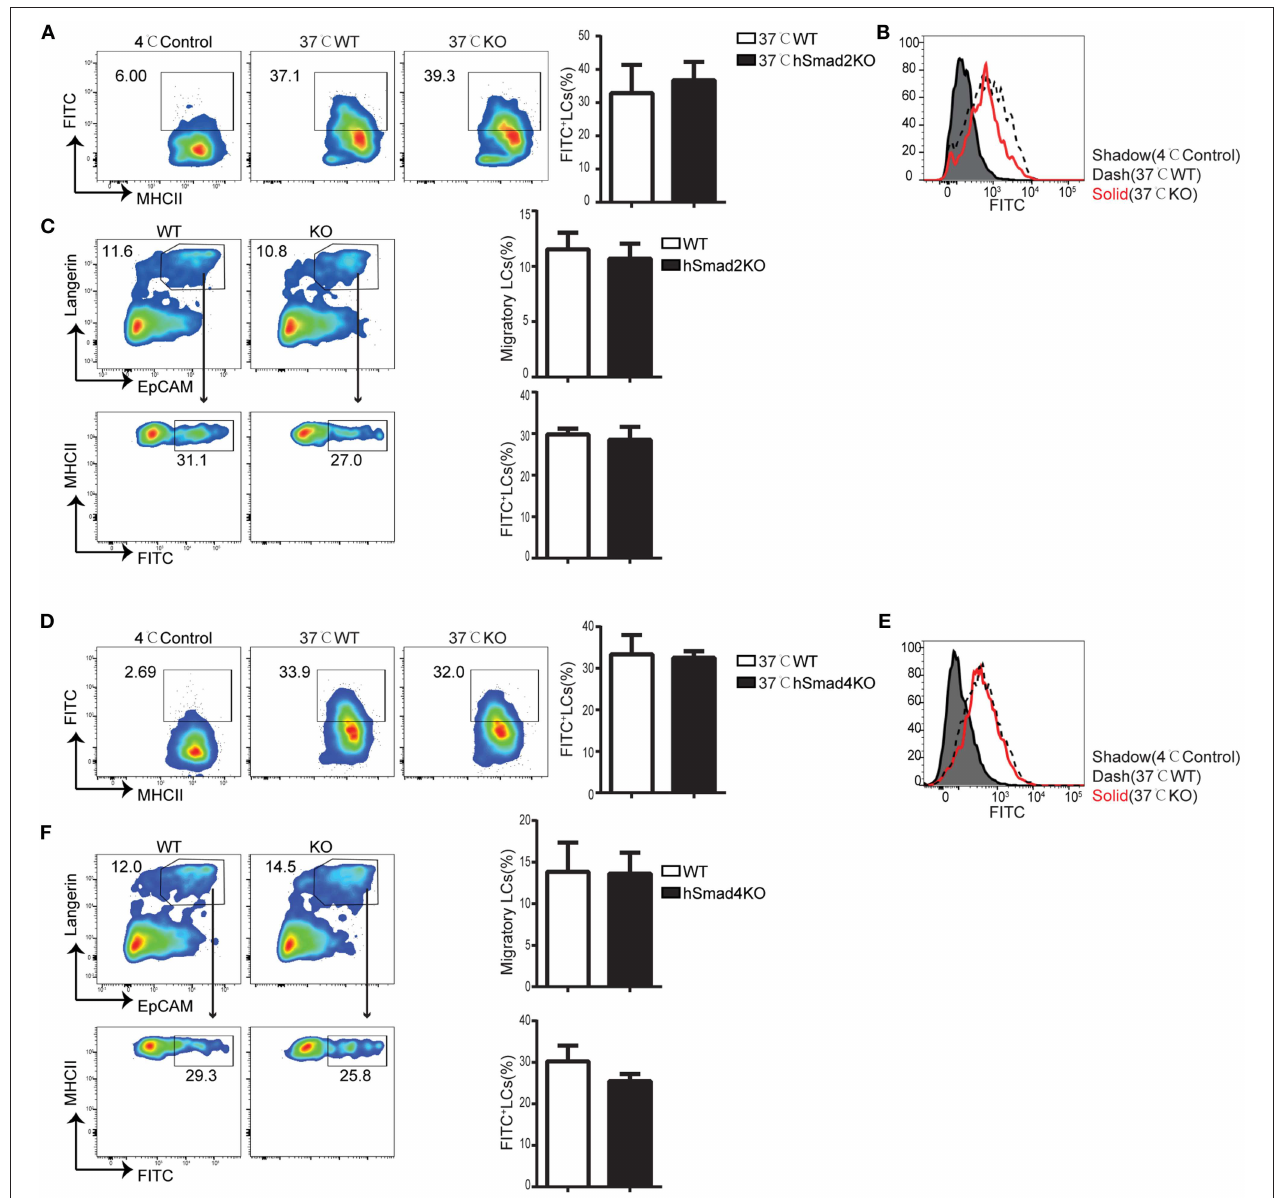
FIGURE 2 | Smad2 or Smad4 deficiency does not interrupt LC phagocytosis and migration. (A–C) In hSmad2KO and WT mice: (A) Representative flow cytometry analysis (left) and the frequency (right) of FITC + LCs (MHCII + FITC + gated on CD45 + cells) after incubation with Dextran-FITC for 45min at 37 or 4 ◦ C (as control) in hSmad2KO and WT mice ( n = 6, P > 0.5); (B) FITC MFI in live LCs was shown; (C) Draining lymph nodes (LNs) were collected 24h after FITC treatment on skin, flow cytometry plots (left) and the frequency (right) of migratory LCs (Langerin + EpCAM + on pre-gated CD45 + MHCII hi cells) (top) and LCs captured antigen (MHCII + FITC + on pre-gated CD45 + MHCII + Langerin + EpCAM + cells)(bottom) were shown ( n = 6, P > 0.5). Data were shown as mean ± SD. (D–F) In hSmad4KO and WT mice: (D) Representative flow cytometry analysis (left) and the frequency (right) of FITC + LCs (MHCII + FITC + gated on CD45 + cells) after incubation with Dextran-FITC for 45min at 37 or 4 ◦ C (as control) in hSmad4KO and WT mice ( n = 7, P > 0.5); (E) FITC MFI in live LCs were shown (F) Draining LNs were collected 24h after FITC treatment, flow cytometry plots (left) and the frequency (right) of migratory LCs (Langerin + EpCAM + on pre-gated CD45 + MHCII hi cells) (top) and LCs captured antigen (MHCII + FITC + on pre-gated CD45 + MHCII + Langerin + EpCAM + cells)(bottom) were shown ( n = 6, P > 0.5). Data were shown as mean ±